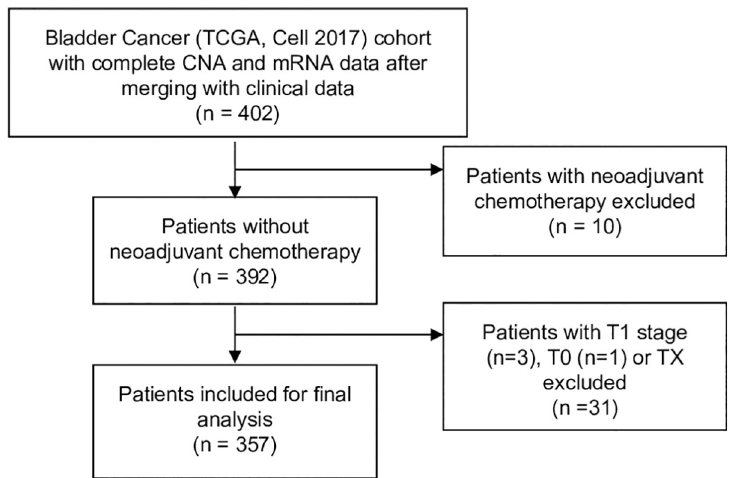
Fig 1. REMARK diagram of the study cohort based on the TCGA cell 2017 MIBC